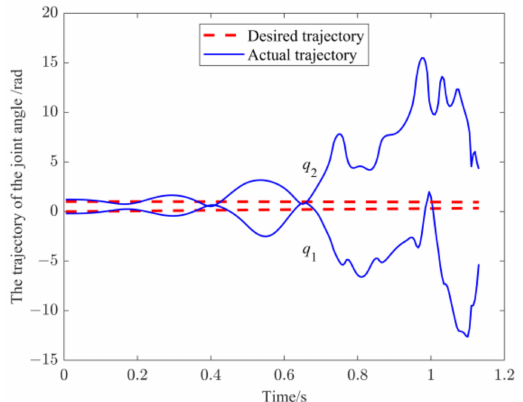
Figure 12. The trajectories of the joint angle q